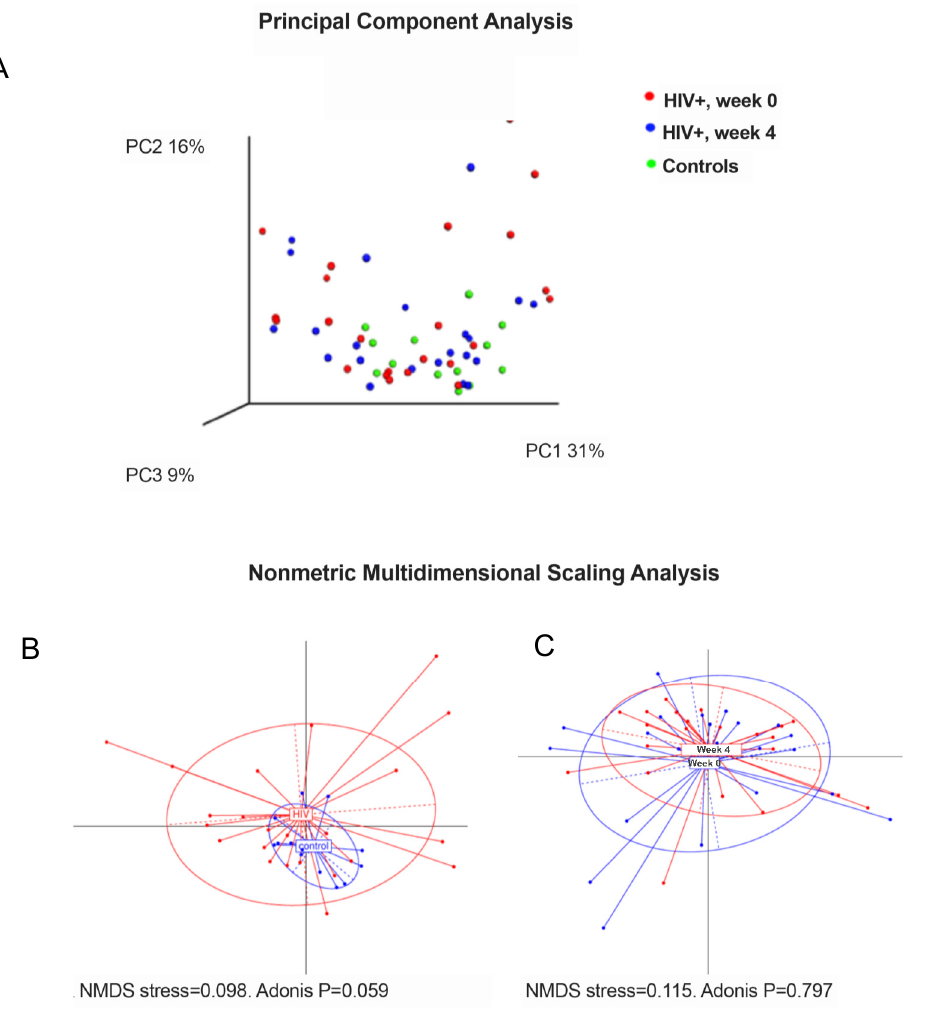
Figure 2. Beta diversity analysis based on weighted Unifrac distances. ( A ), Principal component analysis based on weighted Unifrac distances. HIV-infected children at baseline vs. controls, Adonis p = 0.042; HIV-infected children at week 4 vs. controls, p = 0.272; HIV-infected children at week 0 vs. week 4, p = 0.729. ( B ) Nonmetric multidimensional scaling analysis, HIV-infected children at baseline vs. controls and ( C ) HIV-infected children at baseline vs. week 4. NMDS, Nonmetric Multidimensional Scaling.